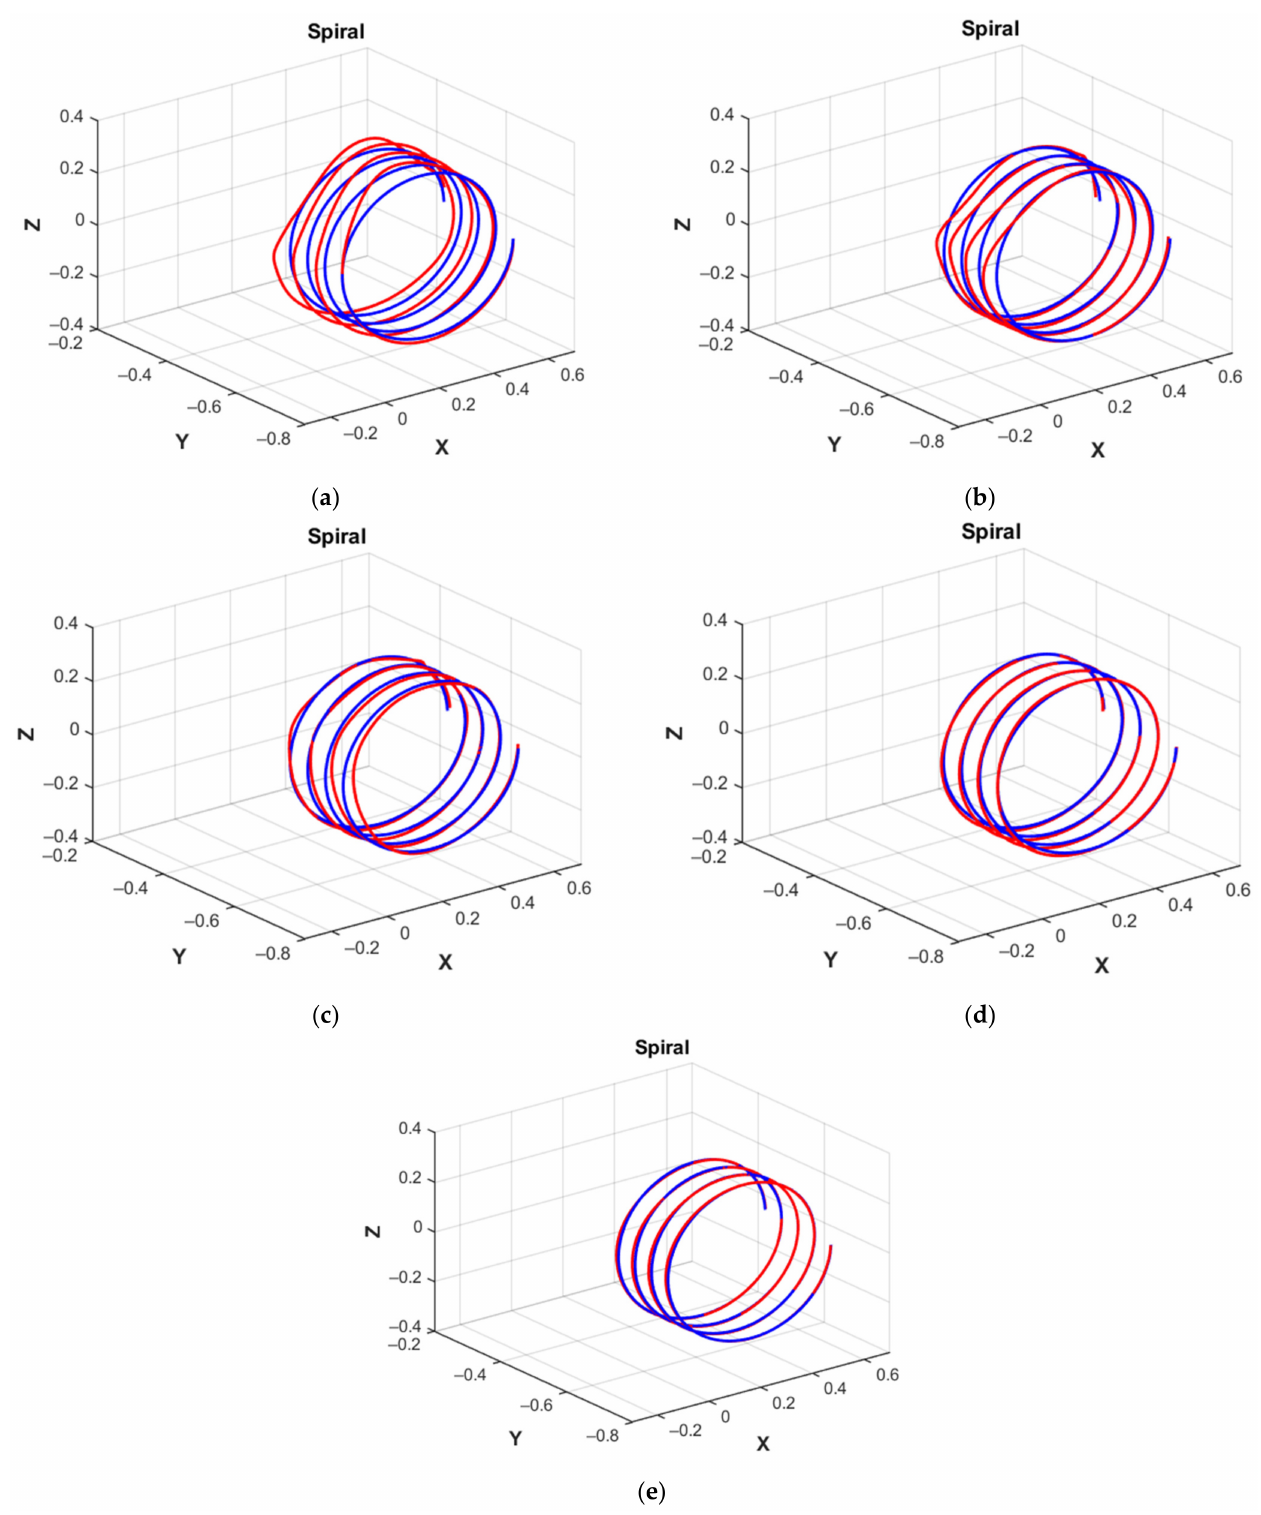
Figure 16. Simulation the movement of the manipulator in a 3D spiral: ( a ) MATRIX NN 1; ( b ) MATRIX NN 2; ( c ) MATRIX NN 3; ( d ) MATRIX NN 4; ( e ) the correctional